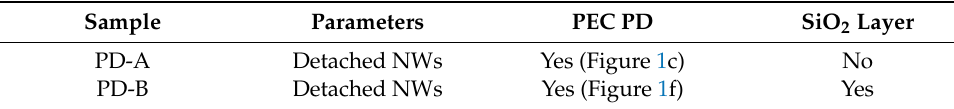
Table 1. Overview of the NW samples used for this work.